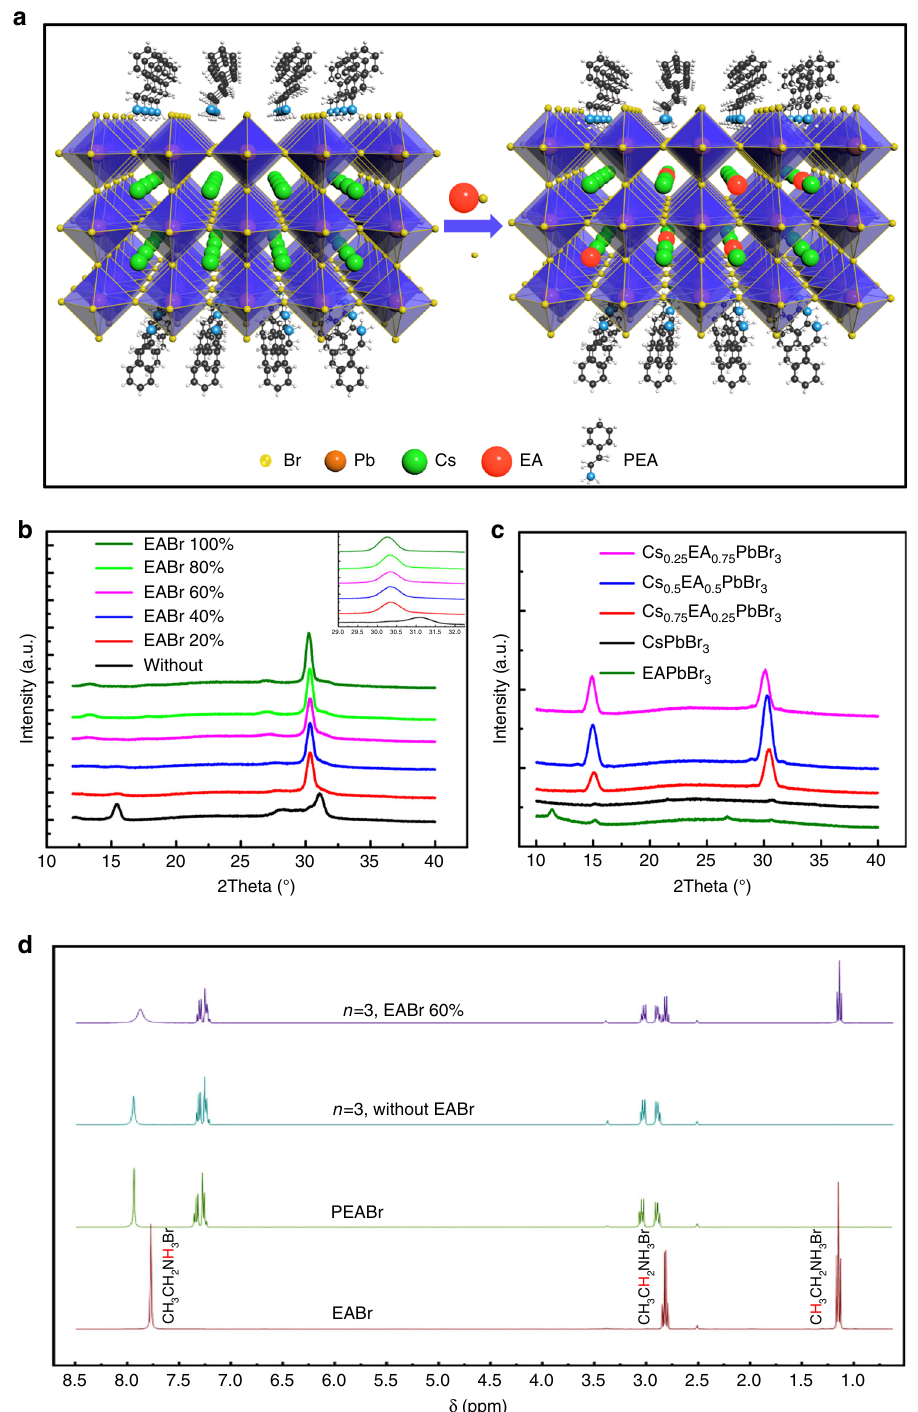
Fig. 2 Crystal composition of perovskite fi lms. a Schematics showing the EA cation doping in the perovskite lattice to replace Cs + in quasi-2D perovskite. b X-ray diffraction (XRD) pattern of the quasi-2D perovskite with different ratio of EABr. The inset is ampli fi ed XRD pattern of samples from 29° to 32°. c XRD patterns of the Cs 1 − x EA x PbBr 3 (0 ≤ x ≤ 1) perovskite thin fi lms. d 1 H NMR spectra of the EABr, PEABr powers and quasi-2D perovskite with or without